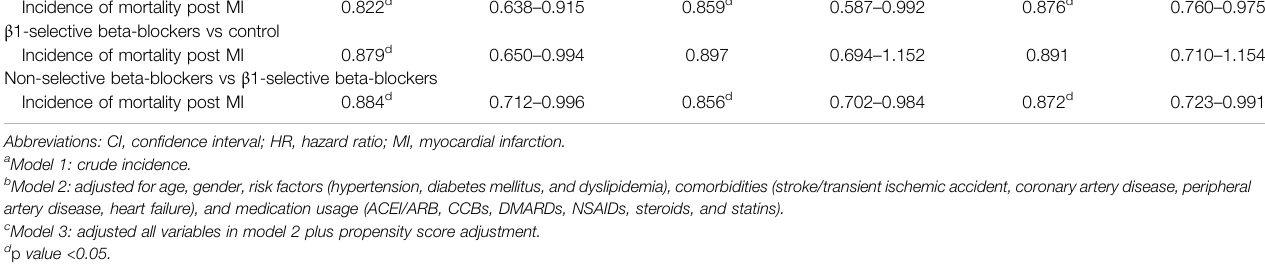
Figure 2 . We plotted survival curves based on the different treatment. The log-rank tests were signi fi cant in the beta- blocker vs control group ( p (cid:1) 0.034) ( Figure 2A ). In Figure 2B , the log-rank tests were reported by using pairwise comparison which were signi fi cant in the non-selective vs control group ( p value (cid:1) 0.027) and β 1-selective beta-blockers vs control group ( p (cid:1) 0.036). However, the comparison was not signi fi cant between non-selective and β 1-selective beta-blockers ( p (cid:1) 0.142).